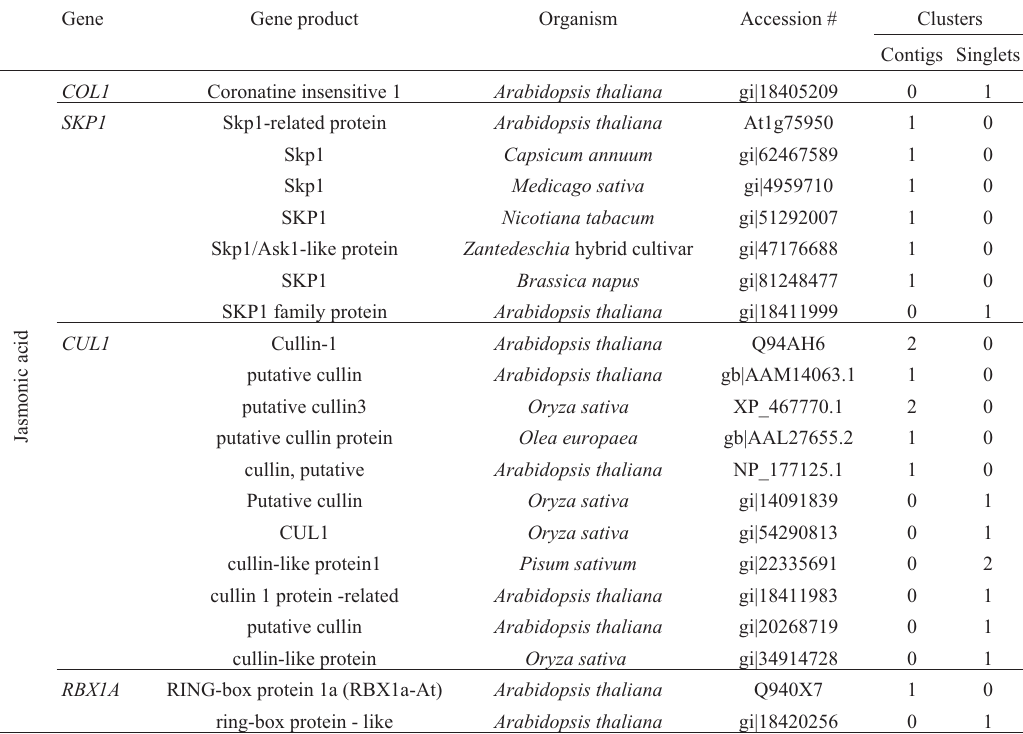
Table 6 - Ortholog genes of Jasmonic Acid signaling pathways found in the Citrus EST database.